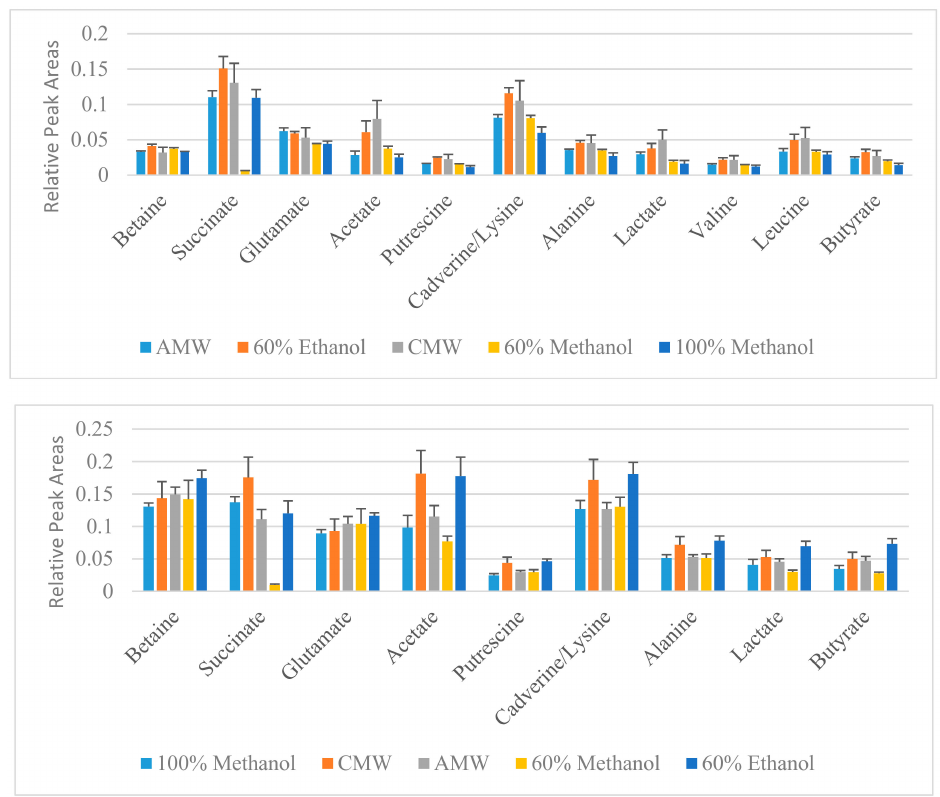
Figure 7. Relativemetabolitelevelsextractedfrom Y.enterocolitica cultures( top )and Y.pseudotuberculosis ( bottom